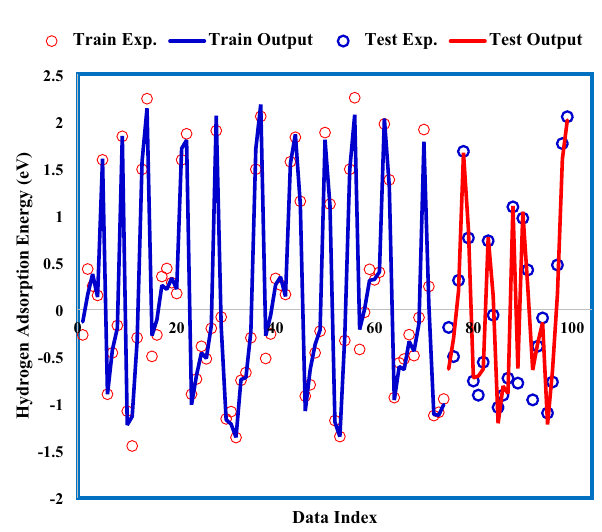
Figure 8. GWO-ANFIS versus experimental hydrogen adsorption energy.